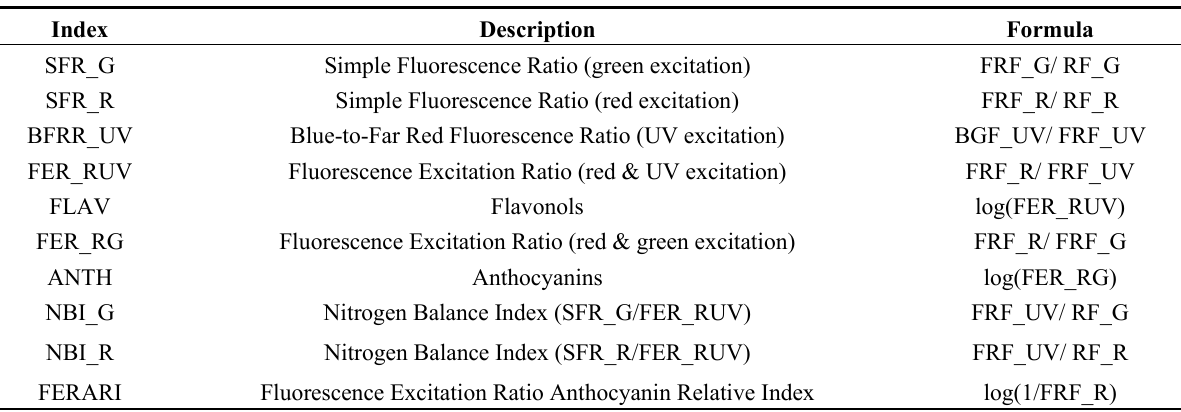
Table 1. Fluorescence indices used in this